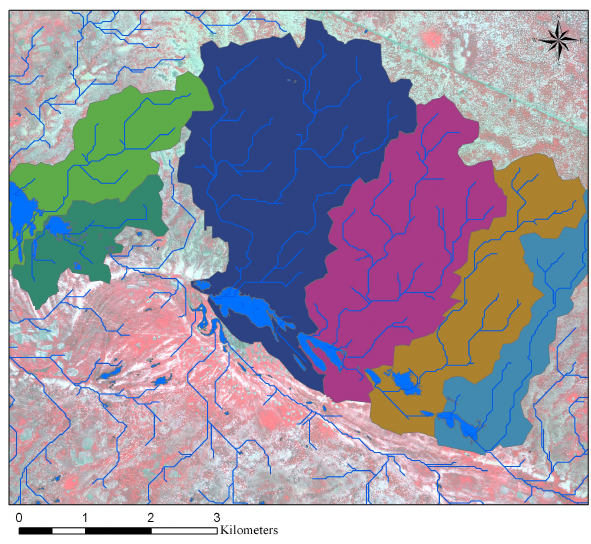
Fig. 4. Catchment area delineation using ASTER DEM. Ferlo val- ley,